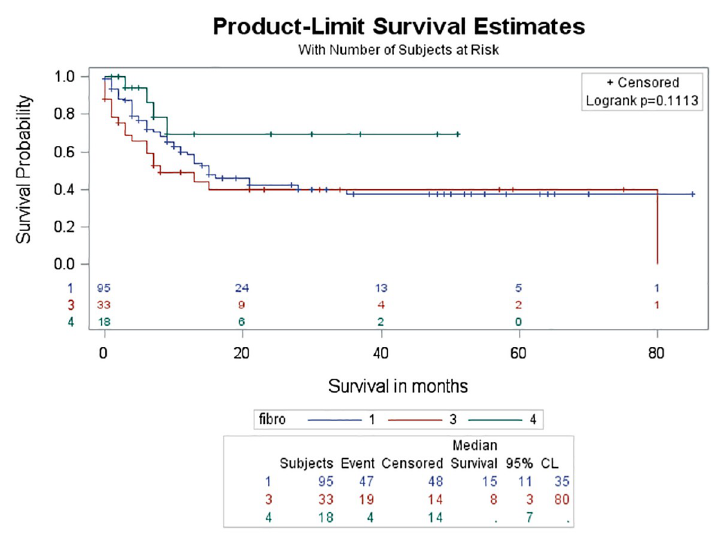
Fig 8. Survival curves between typical and probable UIP compared to other types of ILD. No significant difference was found in survival rate when combining typical UIP and probable UIP types and compared to other types of ILD (log rank test, p = 0.111).